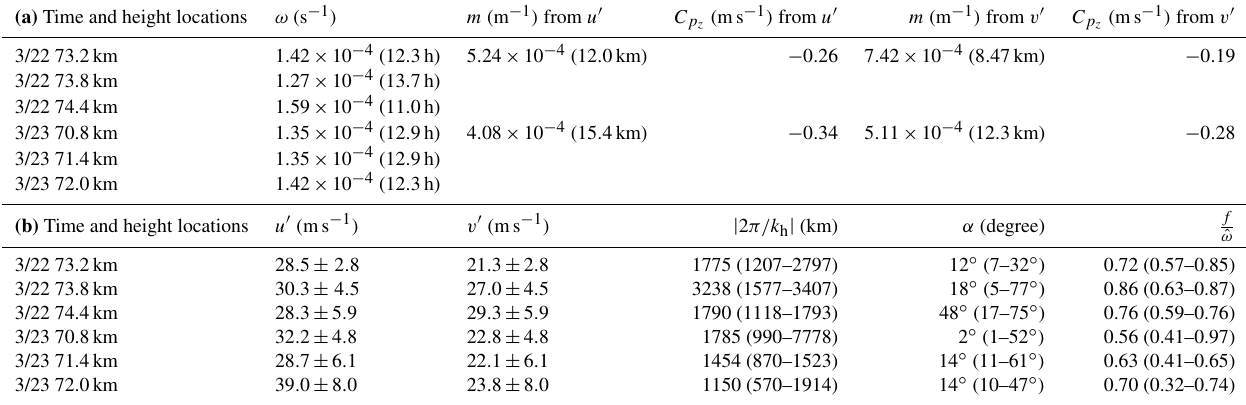
Table 1. The wave parameters of fluctuations in the mesosphere observed over Syowa Station (a) obtained by fitting to a sinusoidal function using a nonlinear least-squares method and (b) estimated on the hypothesis that fluctuations are due to inertia–gravity waves, where α is the angle of u (cid:107) measured clockwise from the east. The error bar is based on the uncertainty by using a nonlinear least-squares method. (a) Time and height